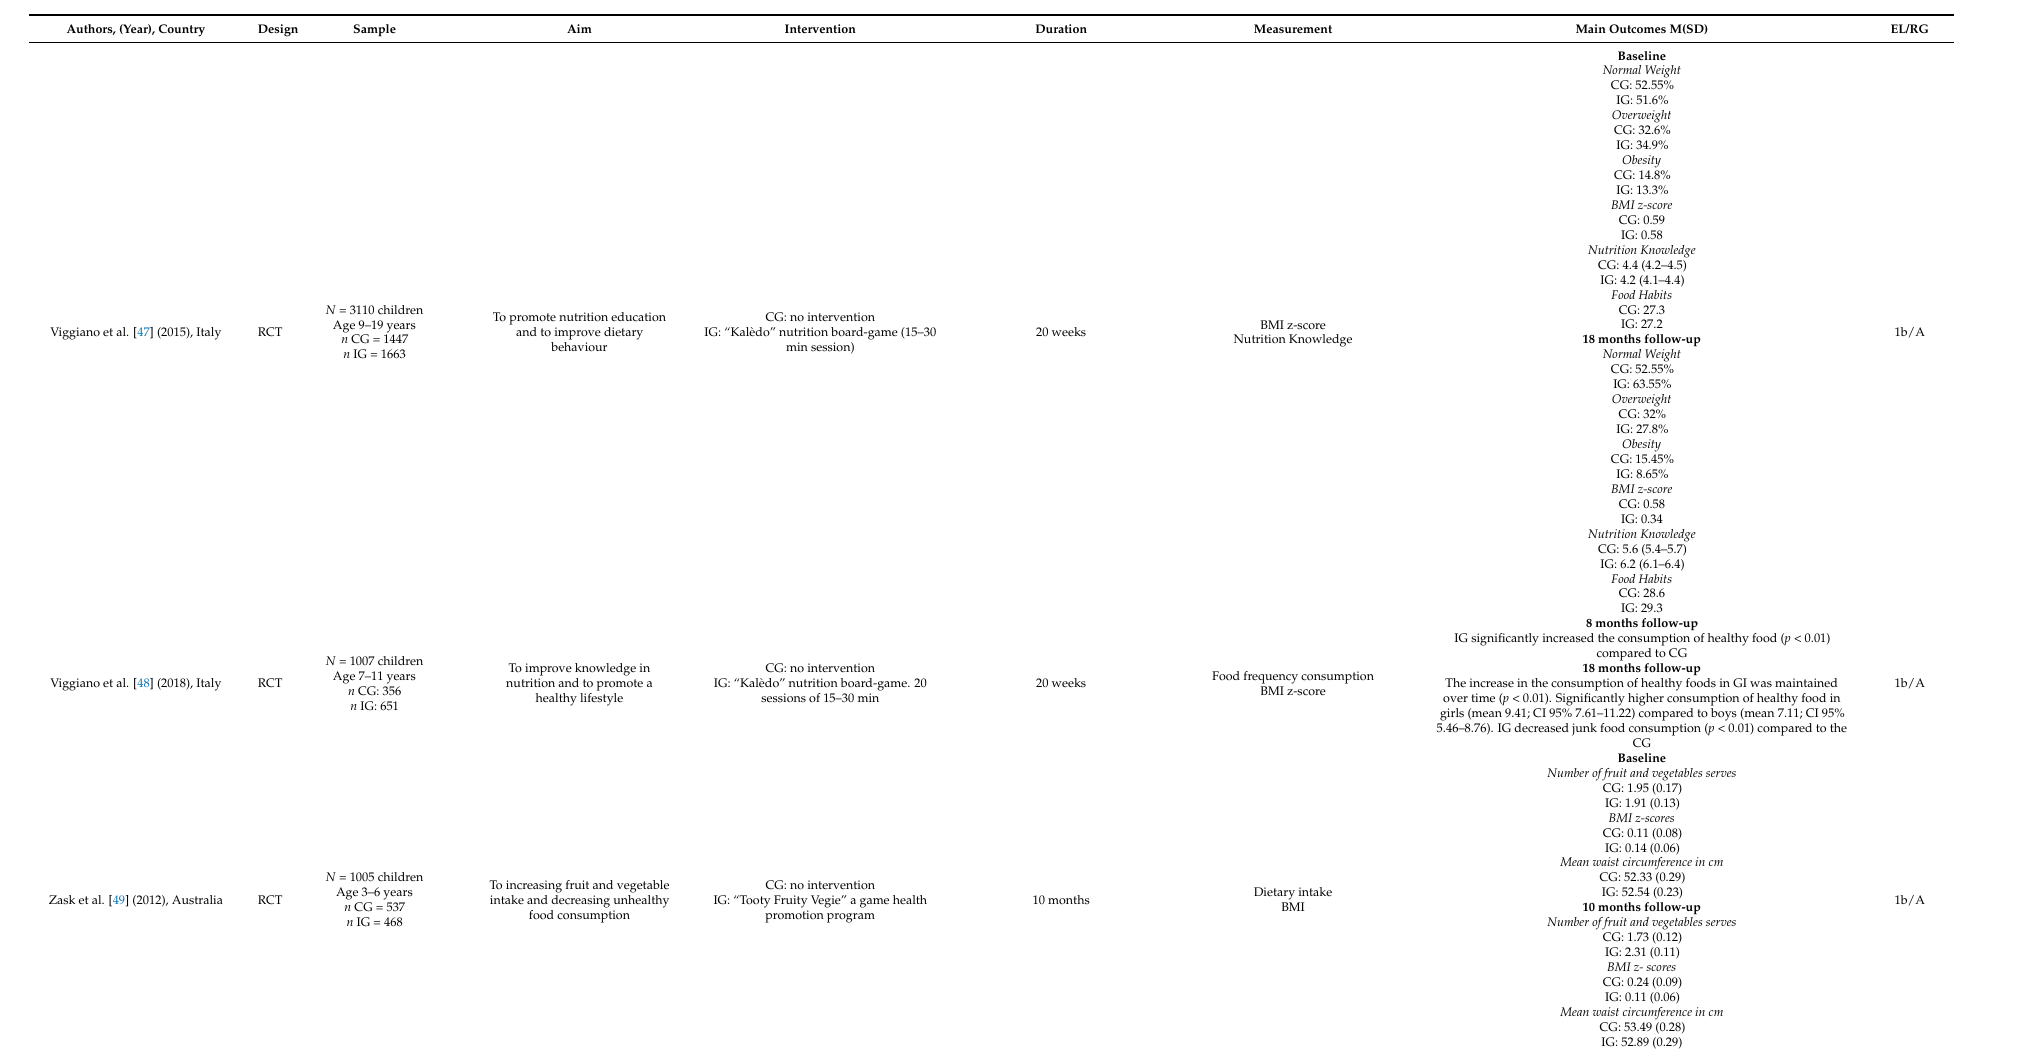
20weeks BMIz-score NutritionKnowledge